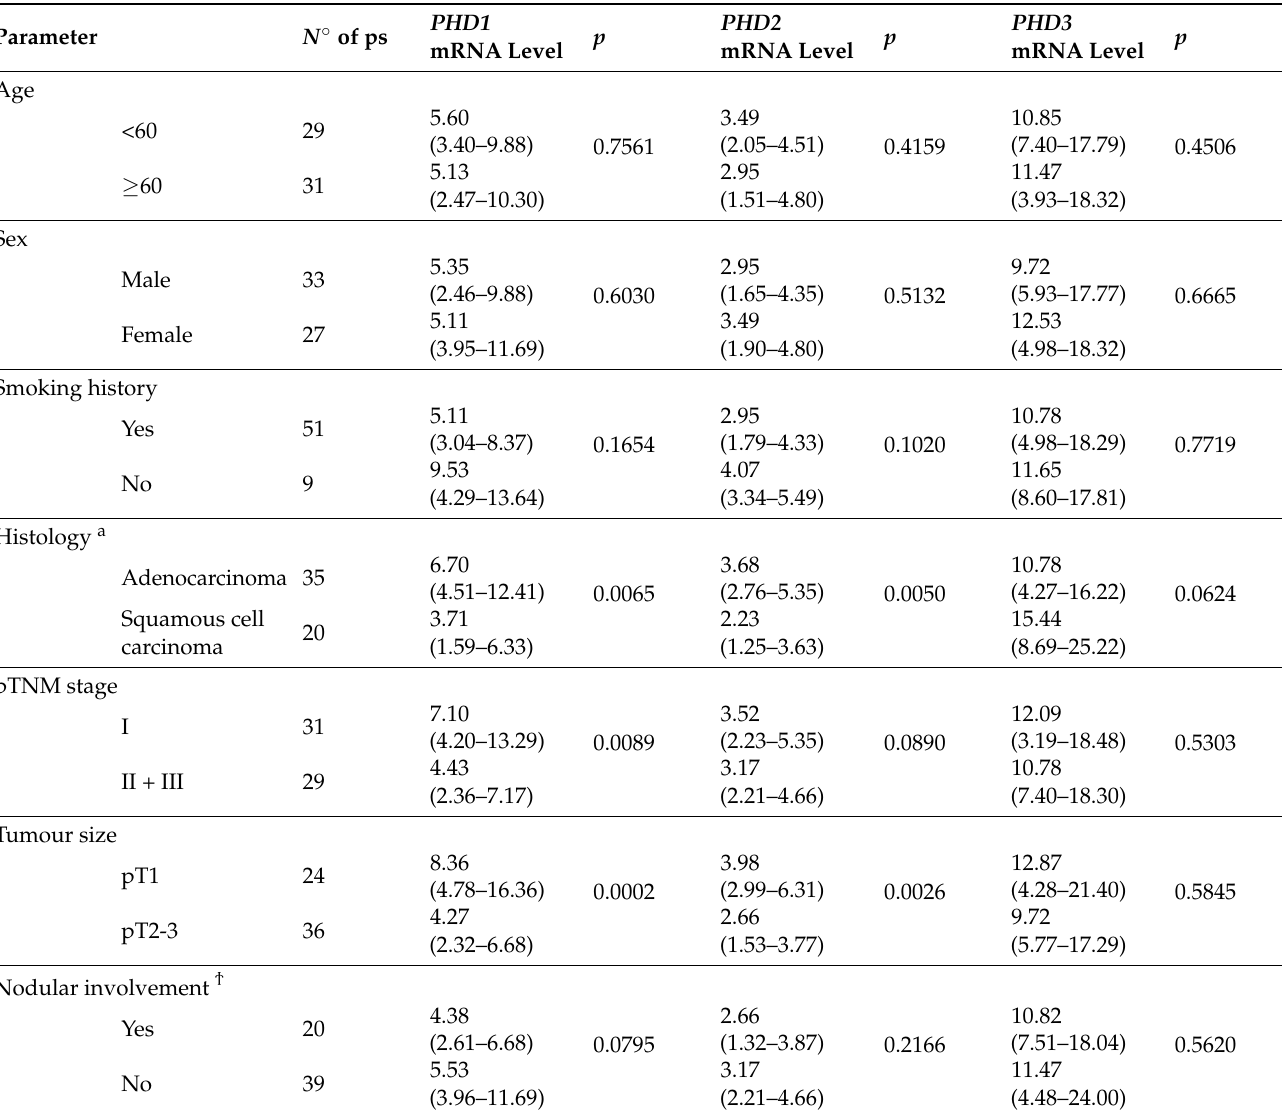
Table 3. Correlations between PHD mRNA expression level and clinicopathological characteristics of 60 surgically resected non-small-cell lung cancer (NSCLC)